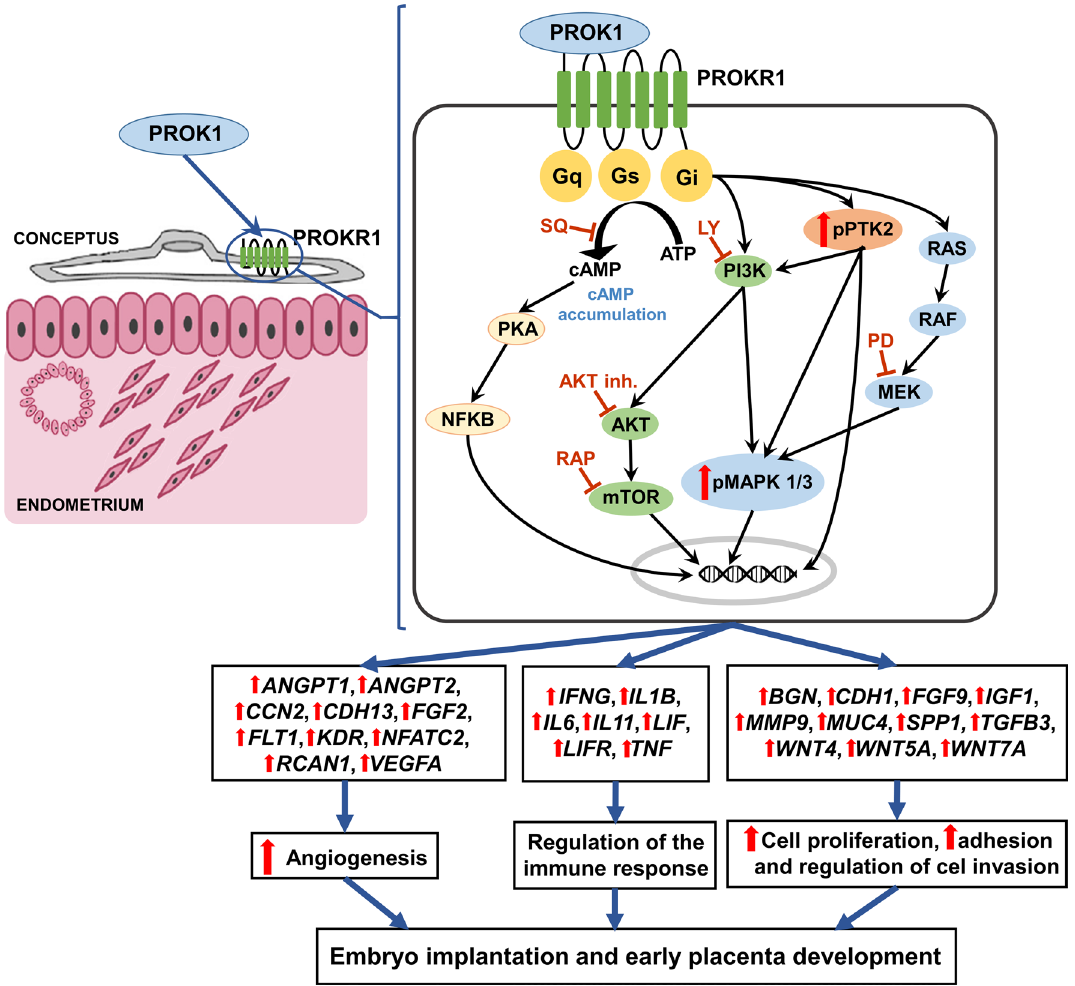
Figure 8. Proposed mechanism of prokineticin 1 (PROK1) contribution to conceptus/trophoblast attachment and early placentation in pigs. A greater abundance of PROK1, acting through PROK1 receptor (PROKR1), promotes primary trophoblast cell proliferation and adhesion. The PROK1-stimulated proliferation of trophoblast cells on days 15 and 20 of pregnancy is mediated by PROKR1 and occurs via phosphoinositide 3-kinase (PI3K), protein kinase B (AKT), mTOR kinase (mTOR) and phosphorylated mitogen-activated protein kinase (MAPK) signaling pathways, and accumulation of cyclic adenosine monophosphate (cAMP). The PROK1-induced adhesion of trophoblast cells is mediated by MAPK (on days 15 and 20 of pregnancy) and PI3K/AKT signaling pathways (on day 20 of pregnancy). Specific inhibitors used for MAPK (PD098059; PD), PI3K (LY294002; LY), AKT1/2 and mTOR (rapamycin, RAP) kinases, as well as for cAMP (SQ22536; SQ) signaling suppress the PROK1-induced proliferation of trophoblast cells. Specific inhibitors used for kinases of MAPK and PI3K inhibit PROK1-induced adhesion of trophoblast cells. PROK1 acting by PROKR1 regulates the expression of the pregnancy-related genes which are involved in processes such as angiogenesis, immunological response, trophoblast cell adhesion, invasion and proliferation. G-proteins q, s and i (Gq, Gs, Gi), RAS protein (RAS), RAF kinase (RAF), protein kinase A (PKA), the nuclear factor kappa-light-chain-enhancer of activated B cell (NFKB), adenosine triphosphate (ATP), phosphorylated mitogen-activated protein kinase 1/3 (pMAPK1/3); phosphorylated protein tyrosine kinase 2 (pPTK2); angiopoietin 1 ( ANGPT1 ); angiopoietin 2 ( ANGPT2 ); cellular communication network factor 2 ( CCN2 ); cadherin 13 ( CDH13 ); fibroblast growth factor 2 ( FGF2 ); fms- related receptor tyrosine kinase 1 ( FLT1 ); kinase insert domain receptor ( KDR ); nuclear factor of activated T cells 2 ( NFATC2 ); regulator of calcineurin 1 ( RCAN1 ); vascular endothelial growth factor A ( VEGFA ); interferon gamma ( IFNG ); interleukin 1 beta ( IL1B ); interleukin 6 ( IL6 ); interleukin 11 ( IL11 ); LIF interleukin 6 family cytokine ( LIF ); LIF receptor subunit alpha ( LIFR ); tumor necrosis factor ( TNF ); biglycan ( BGN ); cadherin 1 ( CDH1 ); fibroblast growth factor 9 ( FGF9 ); insulin-like growth factor 1 ( IGF1 ); matrix metallopeptidase